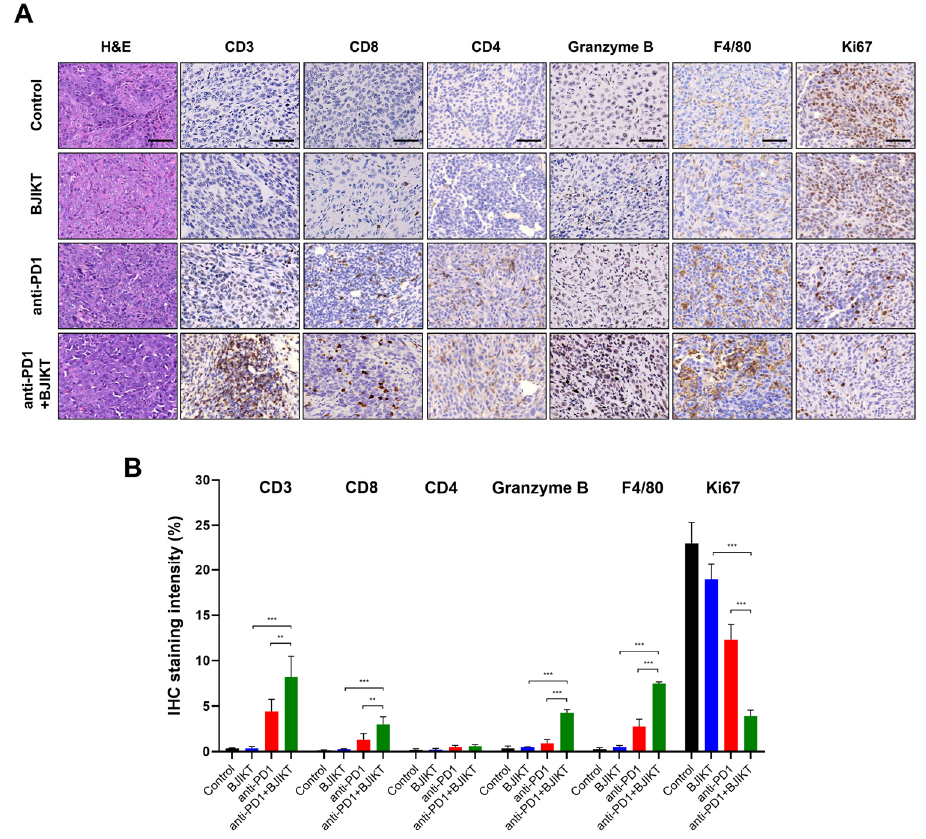
Figure 2. BJIKT with an anti-PD-1 antibody changed the immune profiles in the tumor microenvironment. ( A ) Hematoxylin and eosin staining and immunohistochemistry (IHC) staining findings for the tumor infiltration of immune cells. CD3, CD8, CD4, granzyme B, F4/80, and Ki67 levels were assessed by the microscopic examination of IHC-stained sections. Representative stained sections are shown (scale bars = 50 μ m). ( B ) Quantitative analysis of IHC staining was performed using the ImageJ software. Data are represented as the mean ± SD. ** p < 0.01 and *** p < 0.001, compared to the combination group.